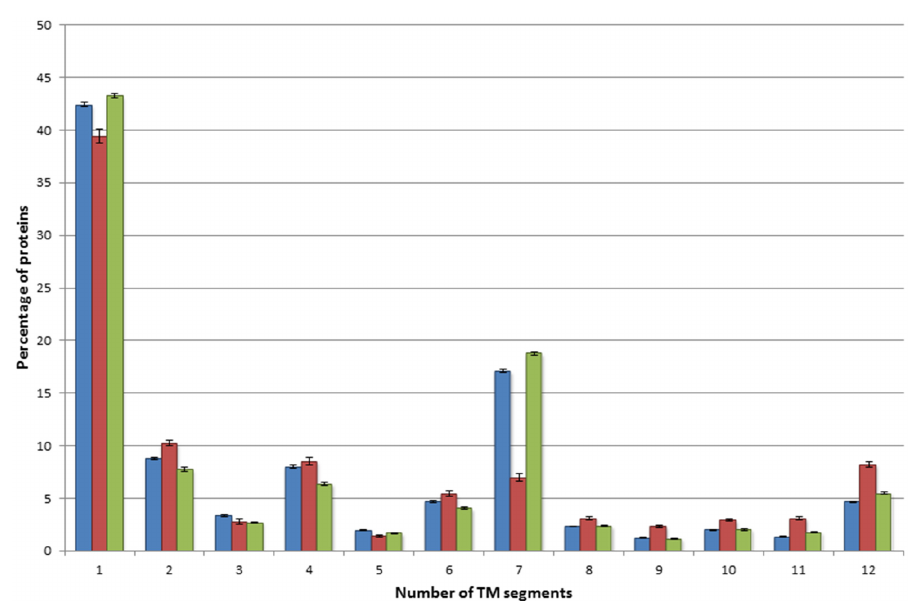
Fig 1. Distribution of genetic variations across transmembrane proteins. Blue bars represent proteins from the Human Transmembrane Proteome database, red bars represent TMPs containing disease- associated mutation(s), green bars represent TMPs containing polymorphism(s). TMPs with more than 12 TM segments were not included in the figure because of the low number of those